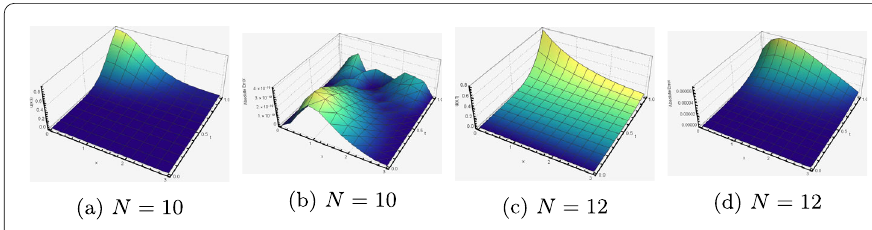
Figure 15 ( a ) and ( b ) represent approximate solution and absolute error distribution, respectively, using SJSCM. ( c ) and ( d ) represent approximate solution and absolute error distribution, respectively, using the